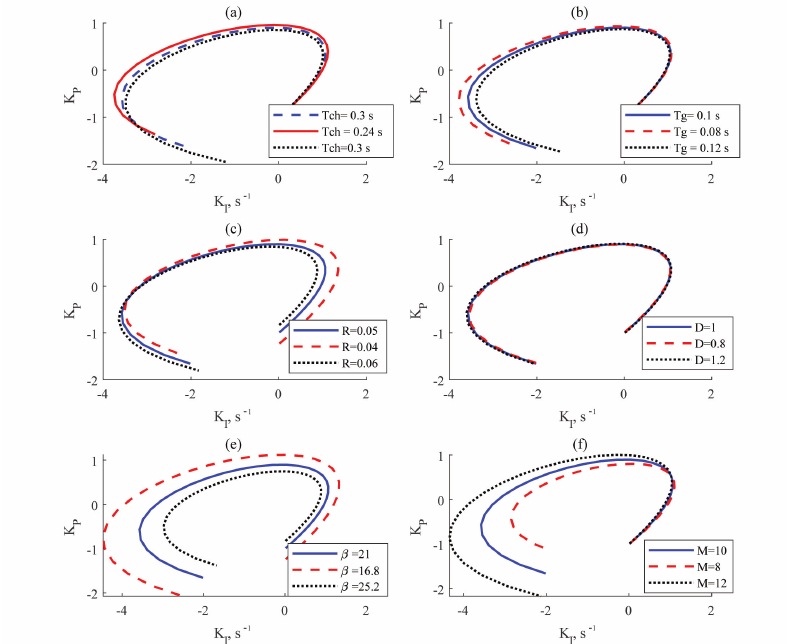
Figure 12. The stability region for single-area LFC system with different values of ( a ) T CH , ( b ) T g , ( c ) R , ( d ) D , ( e ) β , ( f ) M